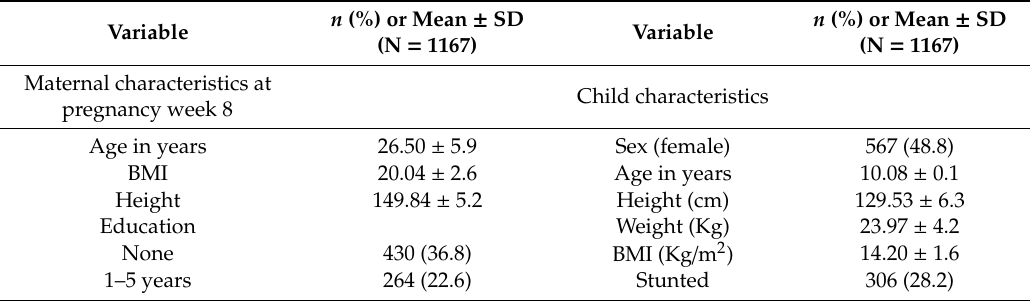
Table 1. Descriptive characteristics of participating children and their mothers.